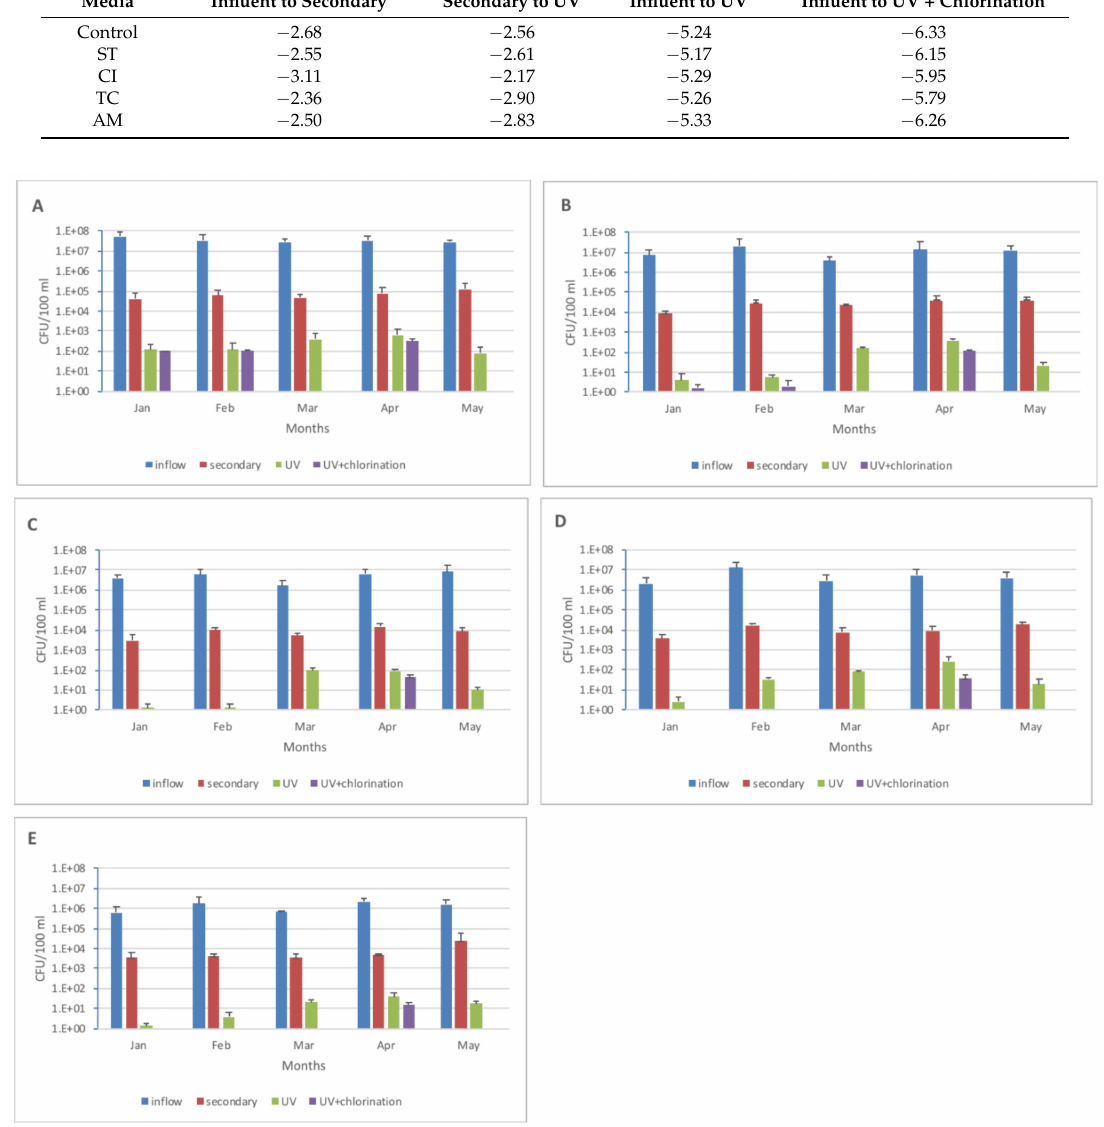
Figure 1. Escherichia coli growth on control ( A ), ampicillin ( B ), ciprofloxacin ( C ), sulfamethoxazole ( D ) and tetracycline ( E ) supplemented